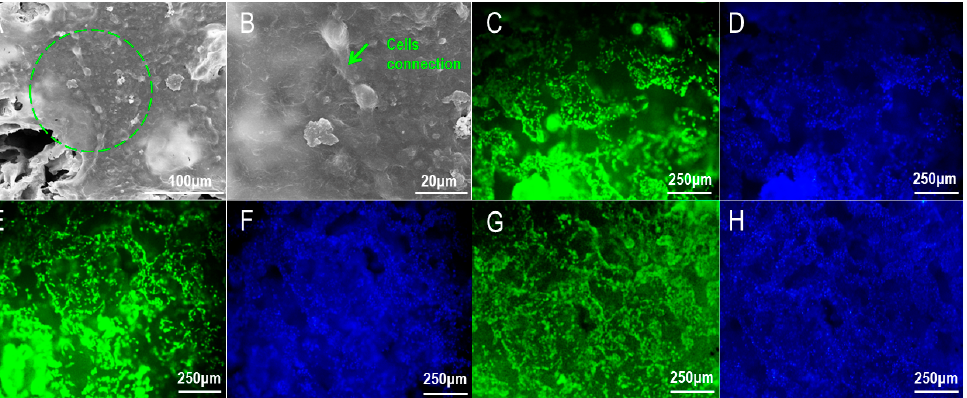
Figure 7. Viability and distribution of osteoblasts on the scaffold. ( A , B ) SEM of cell–scaffold com- pound ( A : ×1000; B : ×3000, The circles represented the zoom position); Hochest and Calcein-AM stainings of ( C , D ) 6% PLA +3% nHAp +2% HAAM; ( E , F ): 6% PLA +3% nHAp; ( G , H ) 6% PLA.